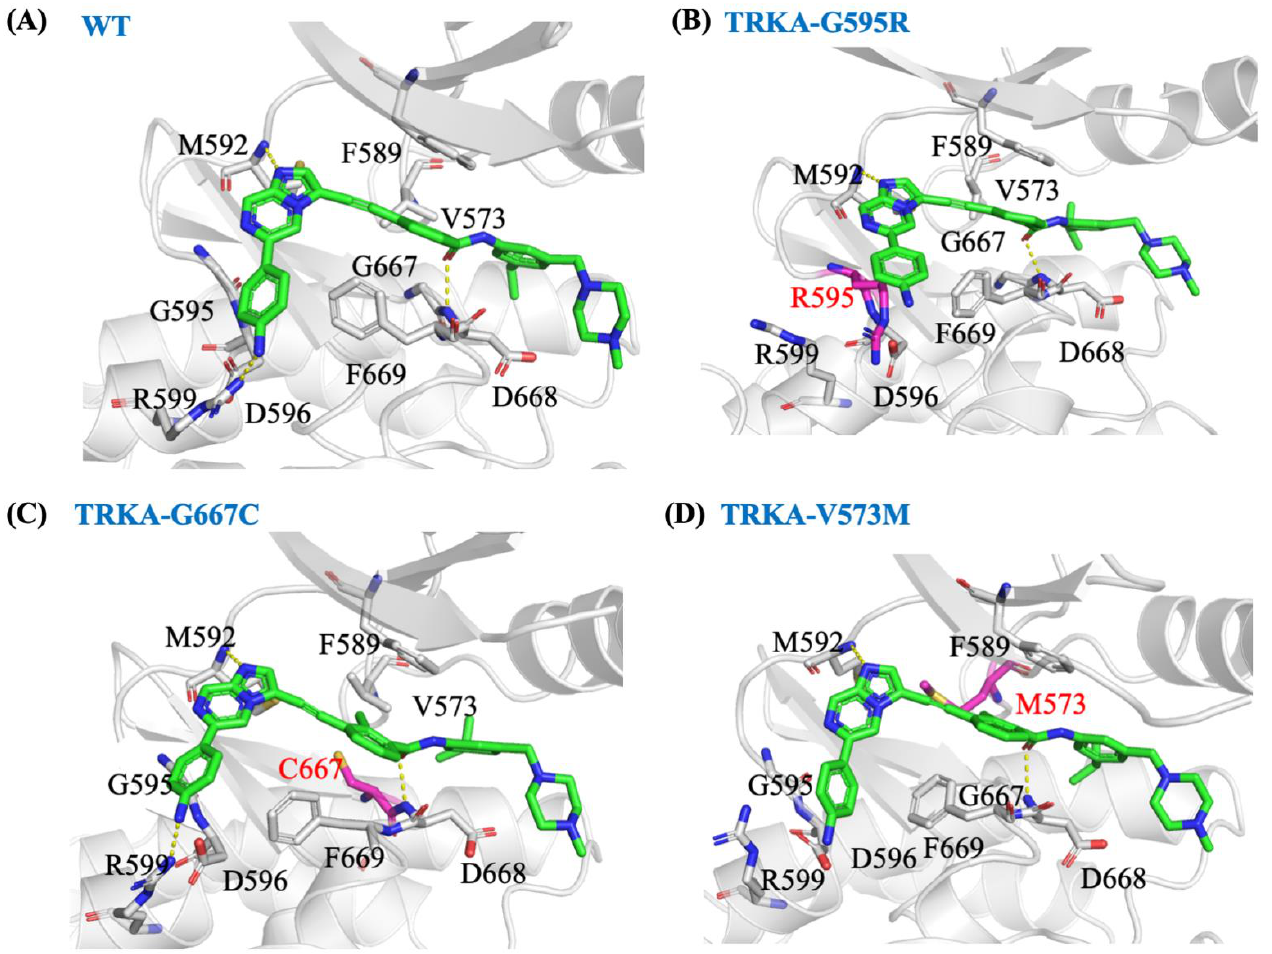
Figure 5. Representative structures for the binding mode of JND4135 in TRKA wild-type and mu- tant from 500 ns MD simulations. Predicted model of JND4135 in complex with wild type TRKA ( A ), TRKA(G595R) ( B ), TRKA(G667C) ( C ), and TRKA(V573M) ( D ). The mutant residues are shown in magenta.